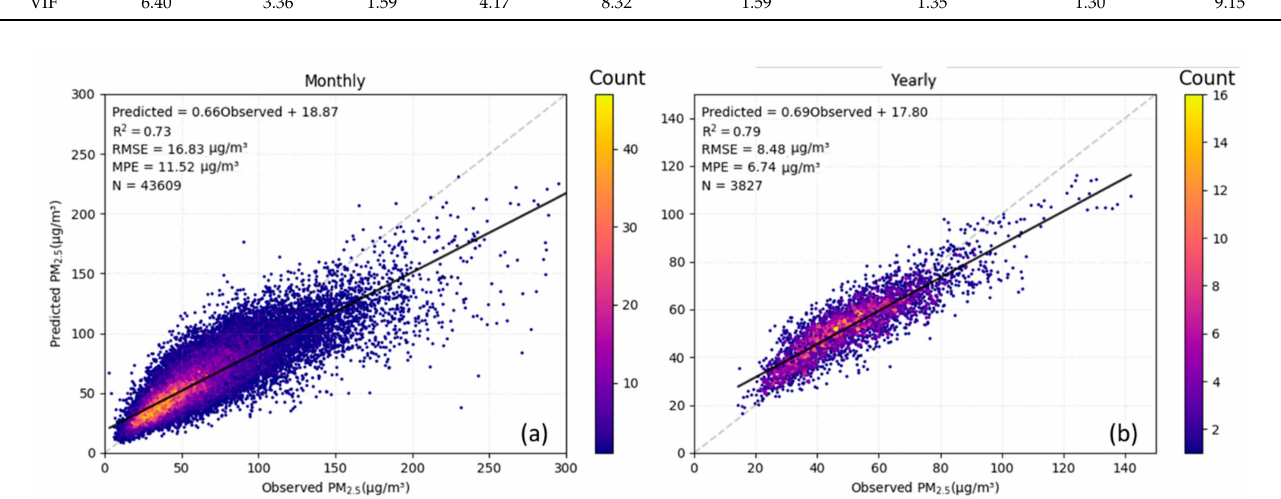
Figure A1. Scatterplot of predicted vs. observed PM 2.5 concentrations at ( a ) monthly and ( b ) yearly timescales. For the monthly/yearly mean observed PM 2.5 , all records from monitors, i.e., including those grid cells where satellite AOD was not available, were averaged, and only those averaged from more than 5/330 valid daily measurements a month/year remained for evaluation.